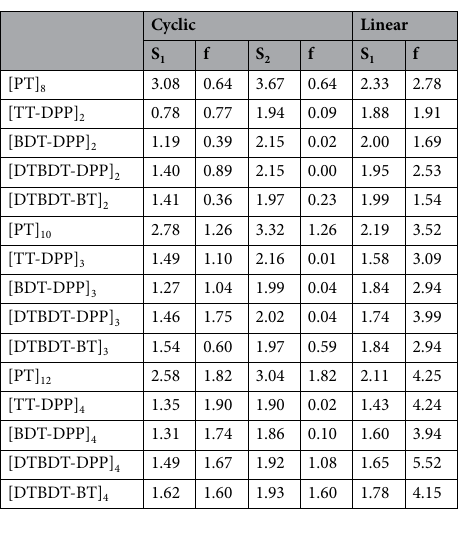
Table 3. Calculated excited state energies (in eV) and oscillator strengths (au) of cyclic and linear molecules determined at mPW1PW91/6-31G** level of theory.